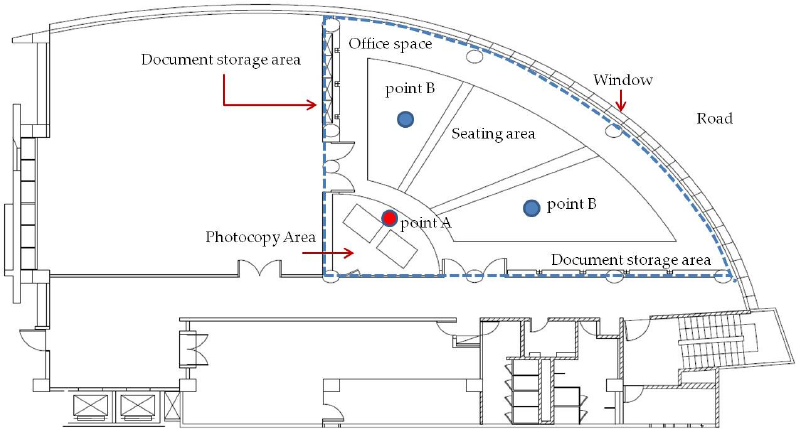
Figure 3. The measured points of the test office.